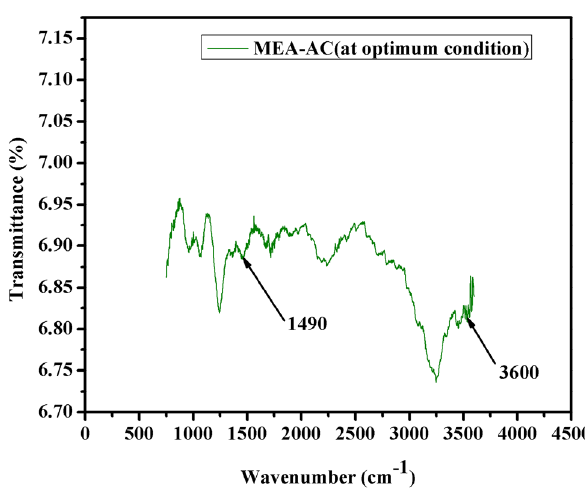
Fig. 13 FTIR Analysis of MEA-AC (at optimum condition)